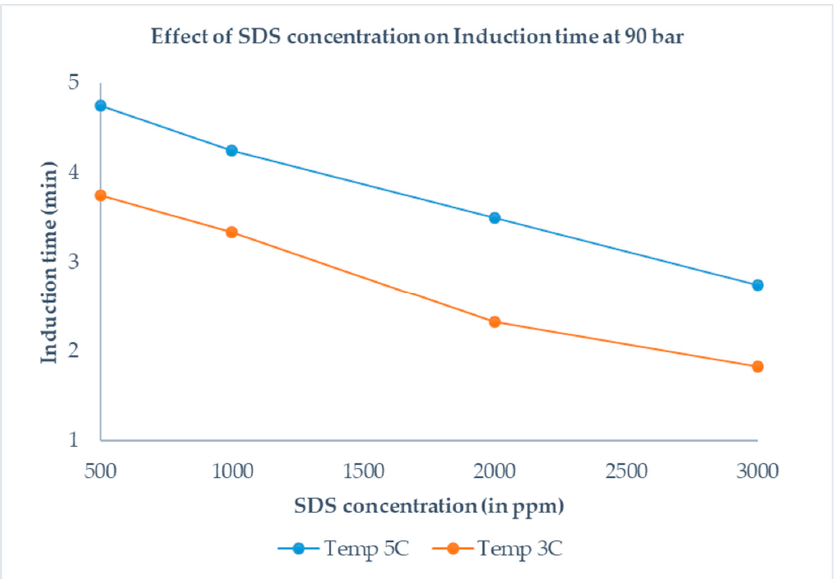
Figure 10. Induction time vs. SDS concentration at 3 °C and 5 °C for a fresh SDS sample. It can be